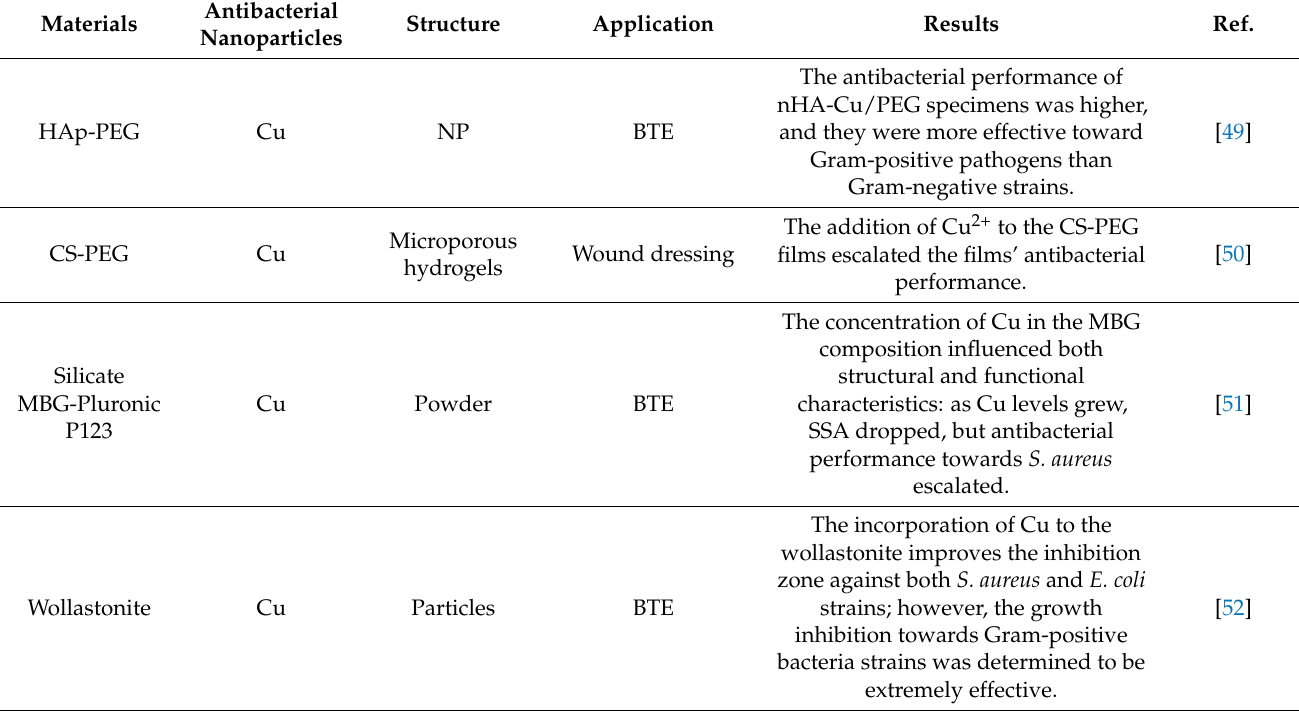
Table 1. Utilization of materials with antibacterial properties in biomedical